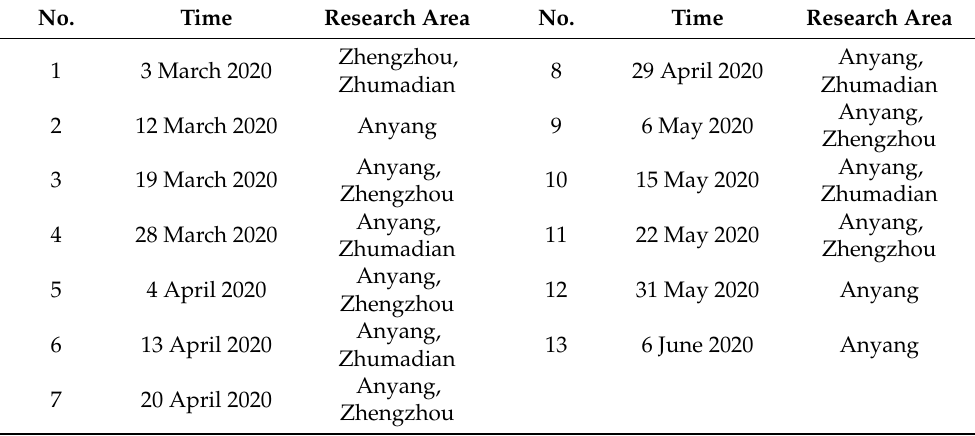
Table 1. List of remote sensing images from Landsat 8 in main research areas in Henan province. No. Time Research Area